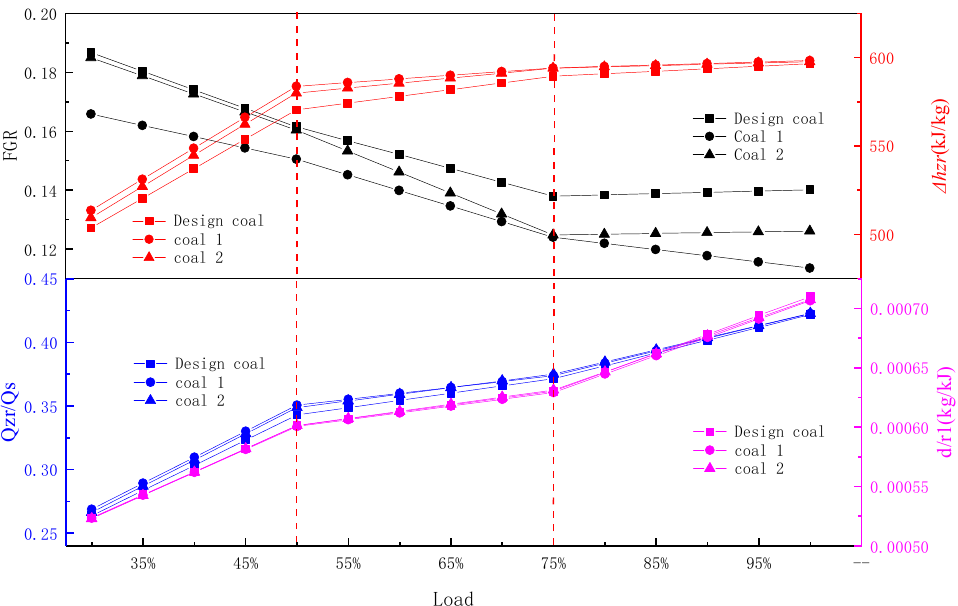
Figure 9. Influence of load on different parameters under different coal quality of reference system.